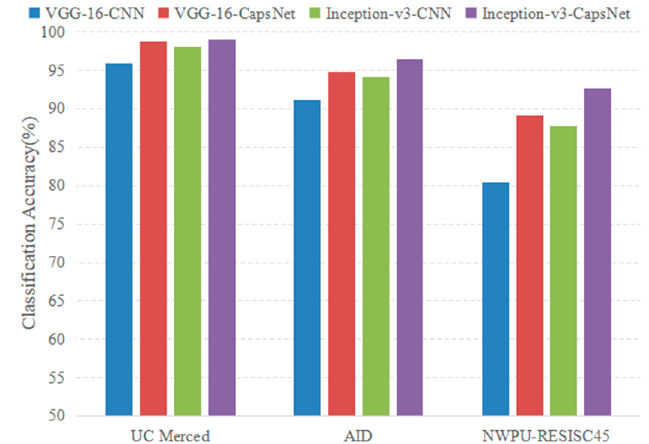
Figure 19. Overall accuracy (%) of the proposed method with neuron and capsule on three datasets.